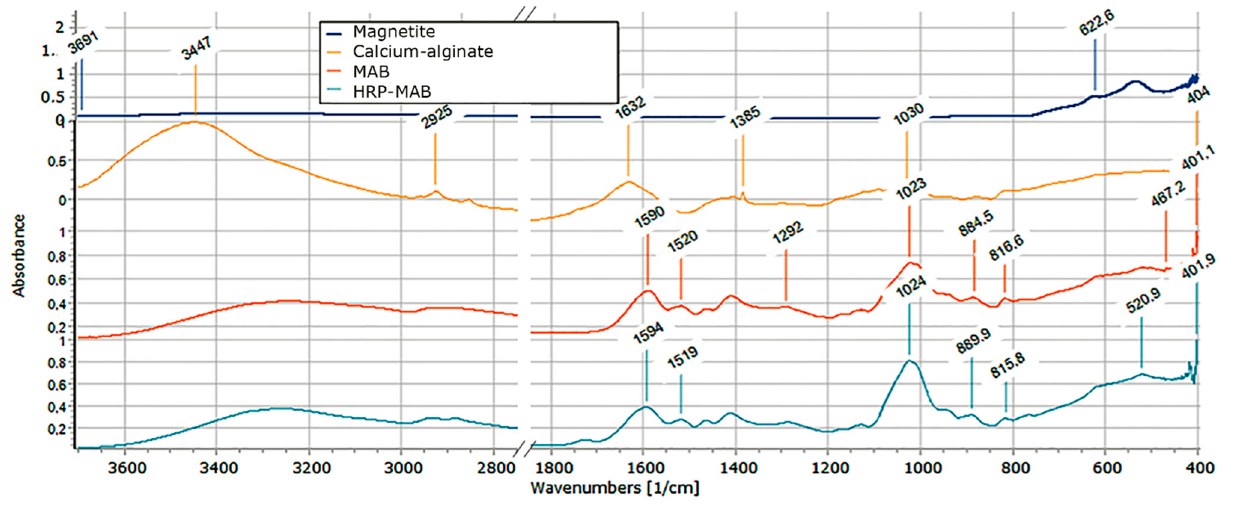
Figure 5. FTIR Spectra of investigated sample: from top to bottom Mag, Ca-alginate, MABs and HRP-MABs, respectively.